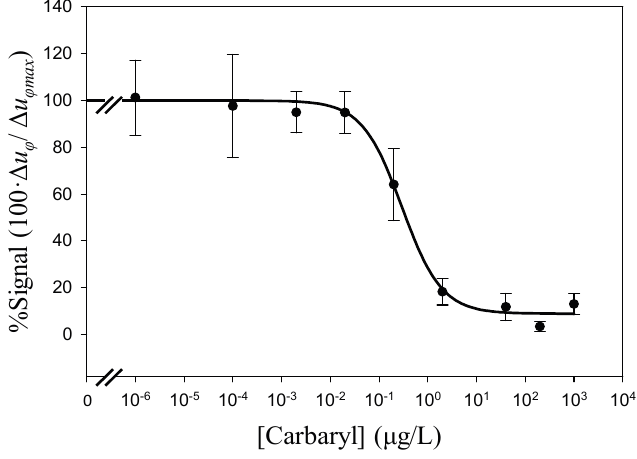
Figure 11. Standard calibration curve of carbaryl for a MAb concentration of 2 μ g/mL and hapten-conjugate concentration of 10 μ g/mL (Curve 2).